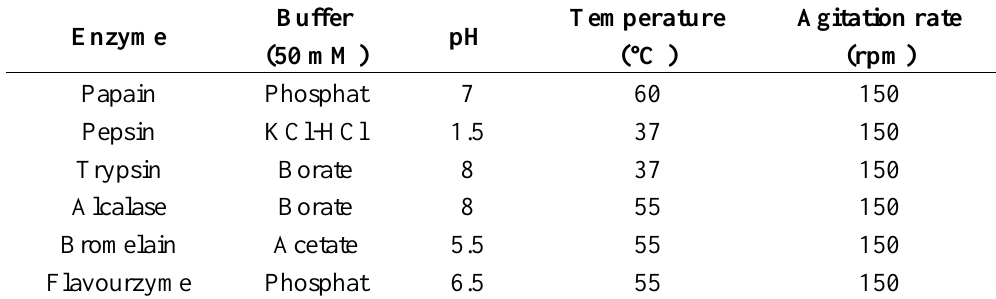
Table 2. Optimum conditions for enzymatic hydrolysis of A. lecanora by different proteolytic enzymes